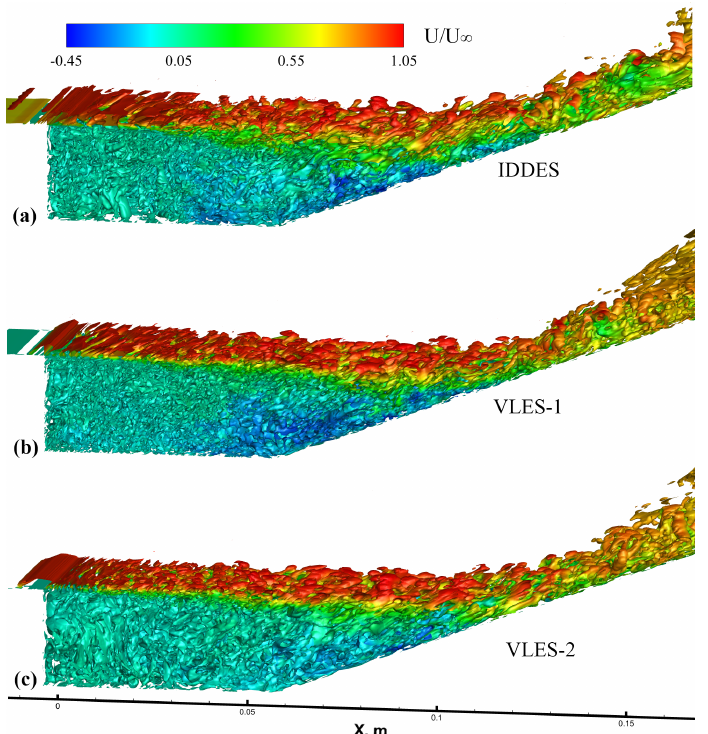
Figure 6. Isosurfaces of Q criterion colored according to the dimensionless streamwise velocity from